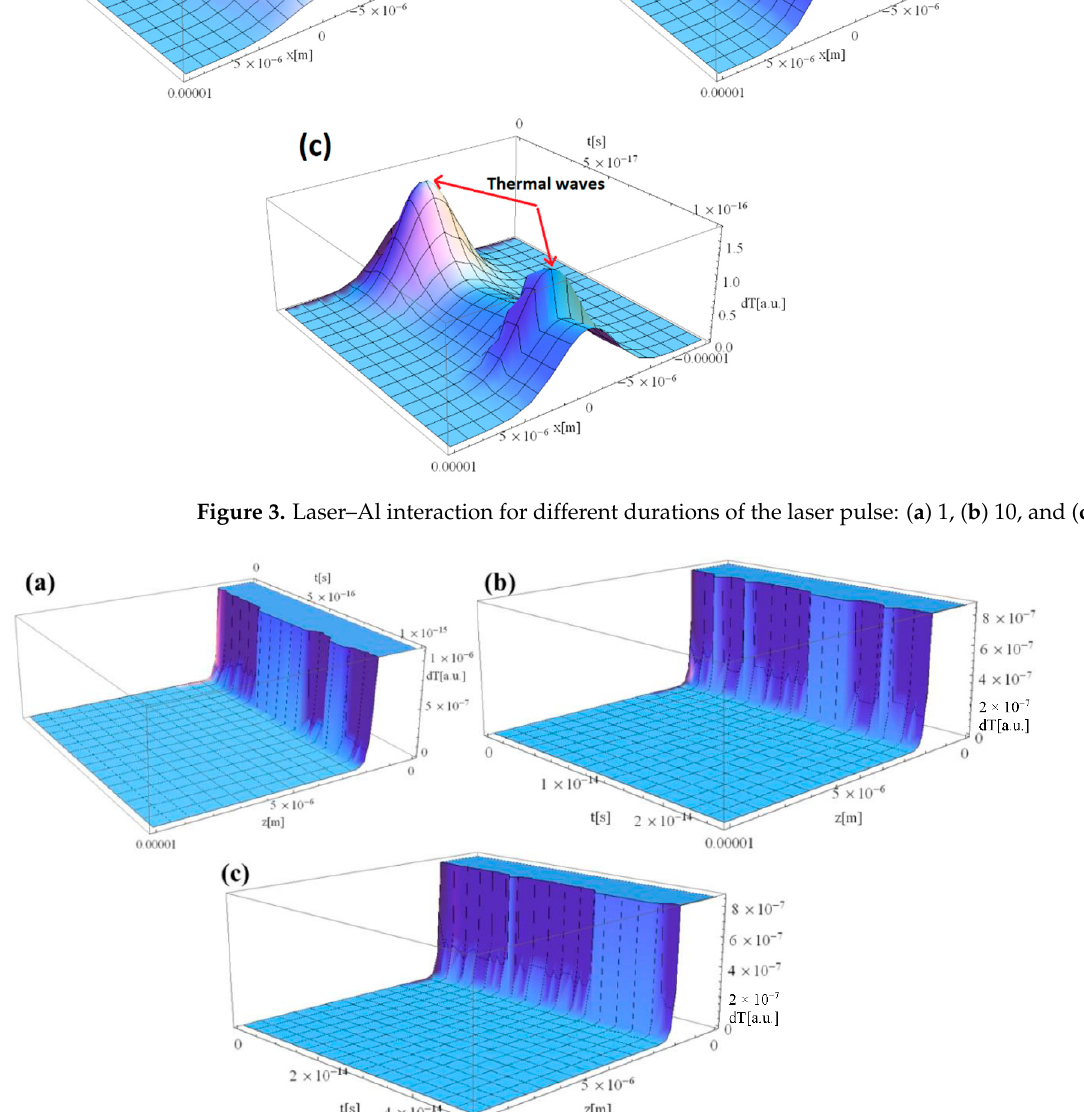
Figure 4. Laser–Al interaction along the sample depth ( z -axis) for different durations of the laser pulse: ( a ) 1, ( b ) 25, and ( c ) 50 fs.